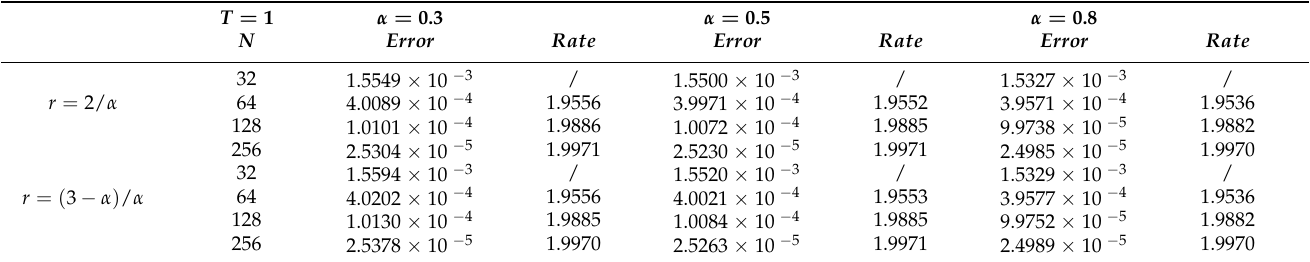
Table 2. Temporal numerical results of (cid:107) u n − U n (cid:107) on graded meshes to Example 1.